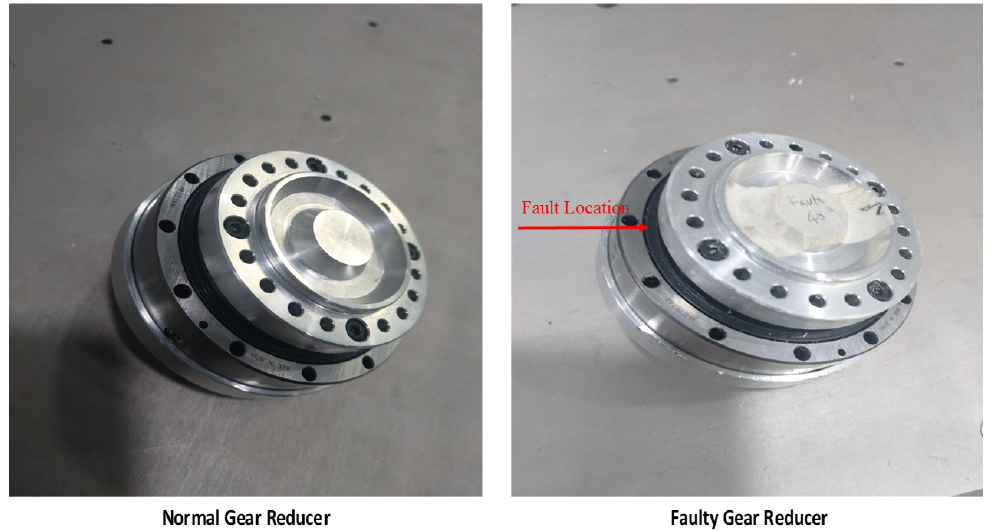
Figure 6. Strain wave gear reducer for Robostar Axis 3: normal and